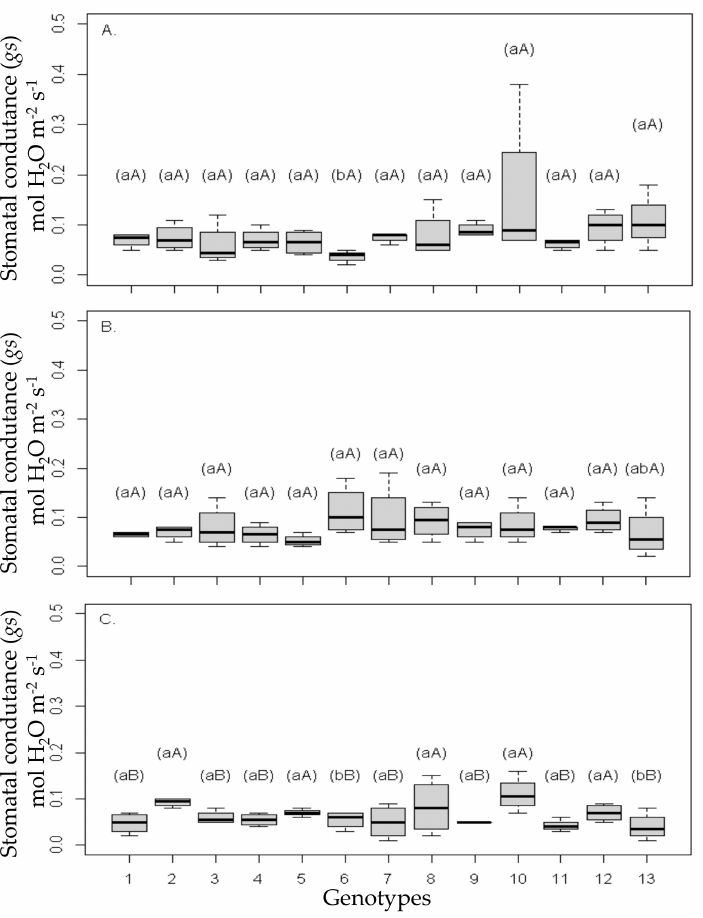
Figure 16. Boxplot relative to the average stomatal conductance ( gs ) of 13 citrus rootstocks in combination with ‘Tahiti’ acid lime ( Citrus × latifolia (Yu. Tanaka) Tanaka) under irrigation with waters of 0.14 ( A ), 2.40 ( B ), and 4.80 dS m − 1 ( C ), in the second year. For identification of genotypes, see Table 1. Boxplots with the same lowercase letter do not differ statistically, according to the Tukey test between salinity levels ( p ≤ 0.05), and those with the same uppercase letter belong to the same genotype group, according to the Scott–Knott test ( p ≤